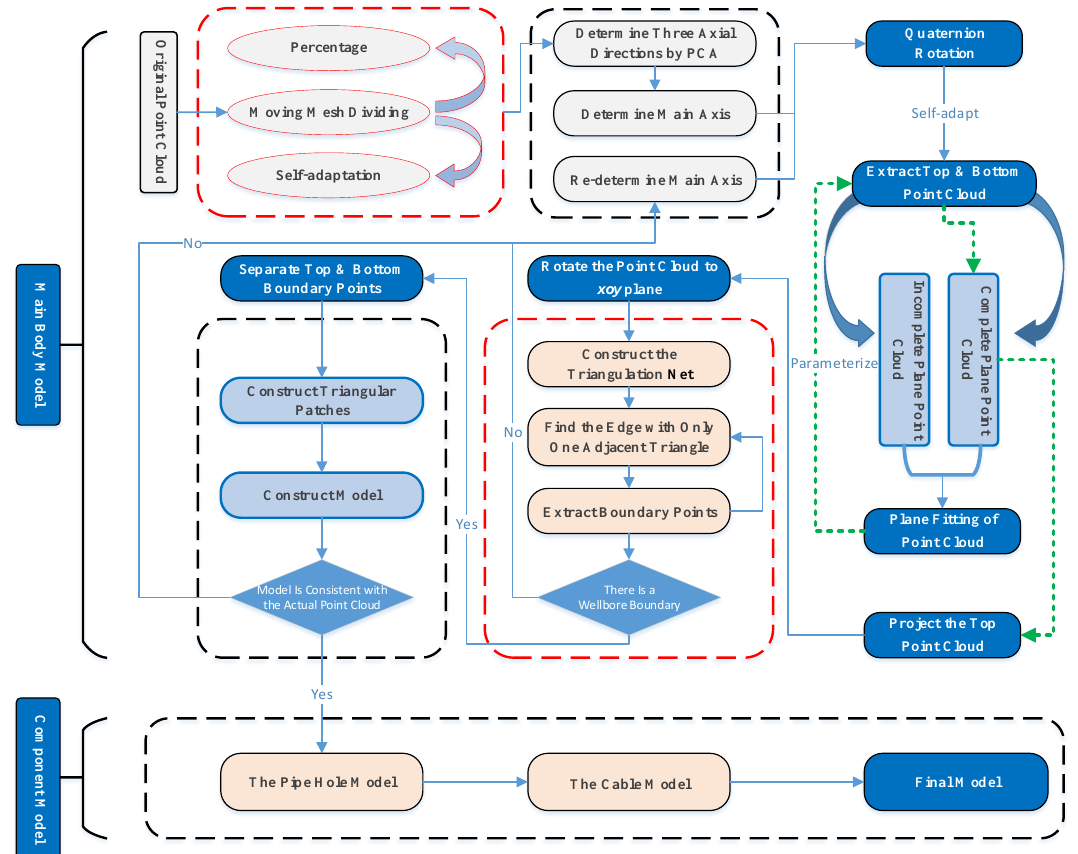
Figure 3. Flowchart of the underground cable well modeling algorithm.